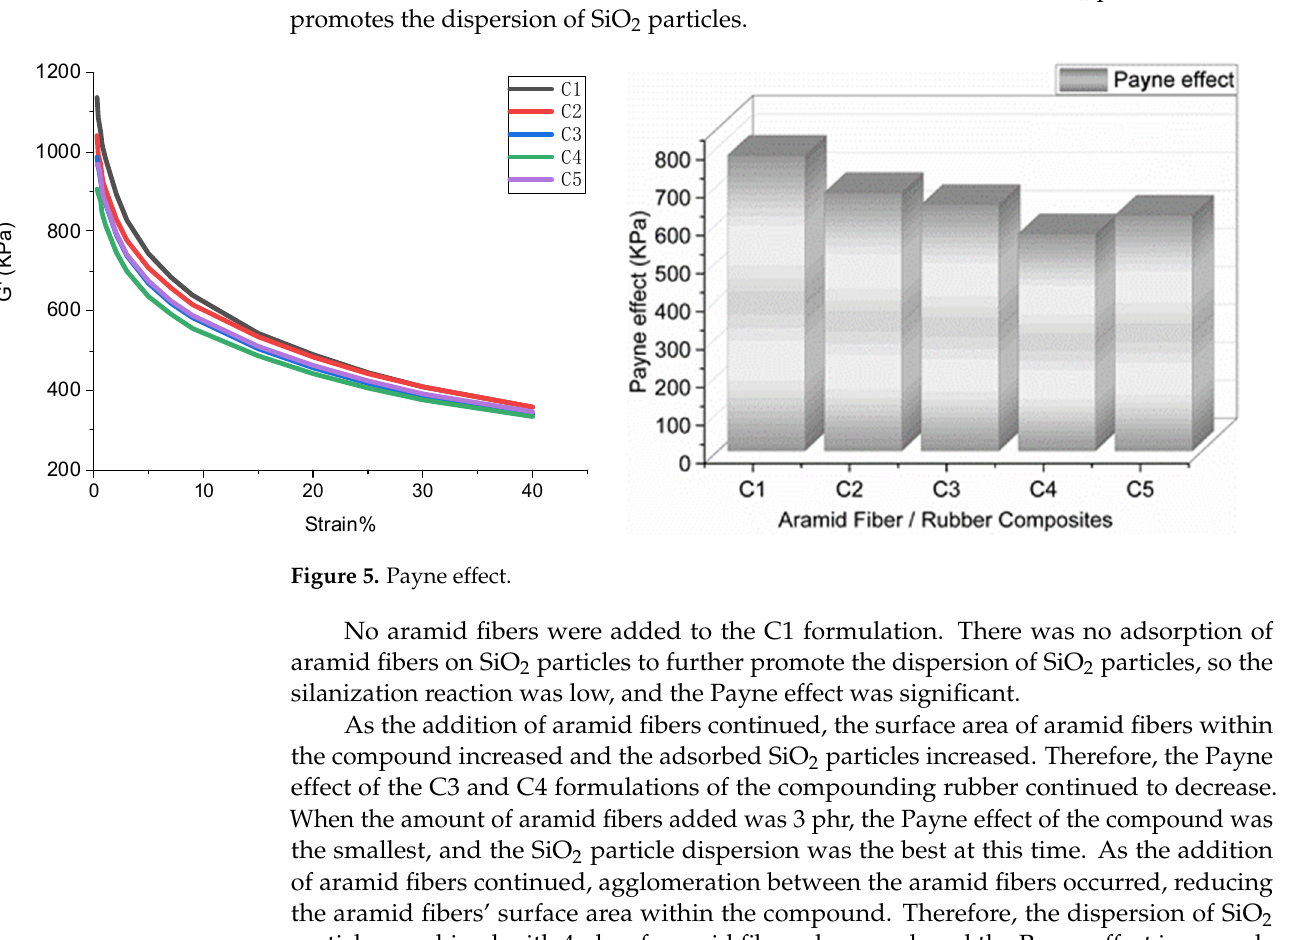
Figure 6. Microstructure of the aramid fiber (20× magnification).